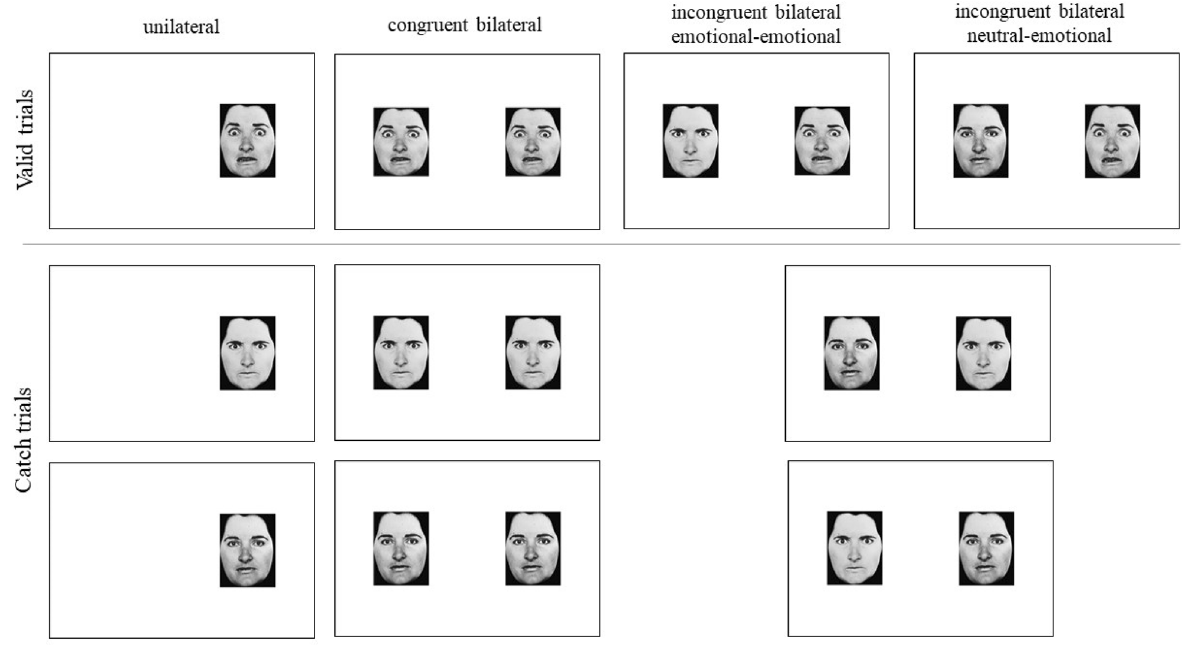
Figure 1. Experimental stimuli when the target was the emotion of fear, showed on the right part of the visual screen, for each of the four experimental conditions (congruent bilateral, incongruent emotional-emotional, incongruent neutral-emotional congruent). In the upper part, the stimuli for the valid trials are showed; in the lower part, for the catch